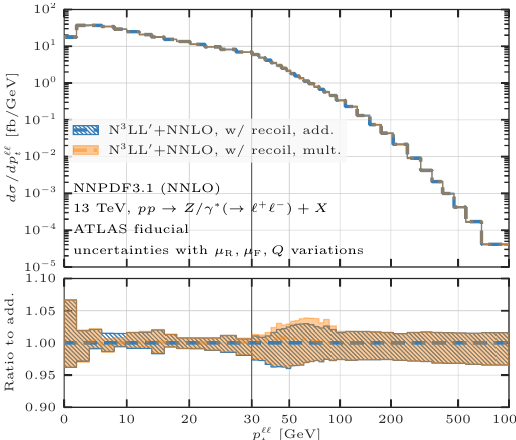
Figure 4 . Comparison of additive (blue) and multiplicative (orange) matching prescriptions at N 3 LL 0 +NNLO, with recoil effects. The x axis is linear up to 30 GeV and logarithmic above. of ‘primed’ effects on the pure resummed prediction induces a distortion in the spectrum which is less than 2% above 5 GeV, and that can be as large as a few percent below, which is qualitatively consistent with (and quantitatively less pronounced than) what is shown for the NNLL 0 versus NNLL comparison in the left panel of figure 1, featuring the same central-scale setup. The uncertainty band undergoes a significant reduction below 10 GeV in passing from N 3 LL to N 3 LL 0 accuracy, by up to a factor of 2 towards p ‘‘ matched results shown on the right panel largely inherit the features just described in the phase-space region dominated by resummation effects, whereas for p ‘‘ prediction is dominated by the fixed-order component, which is common to both. Overall, the N 3 LL 0 +NNLO residual uncertainty band is at the level of 2 - 3% below 30 GeV (barring the first bin), and around 5% above 30